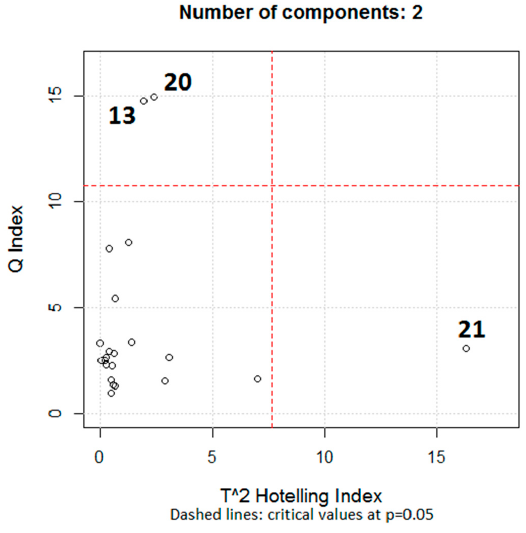
Figure 4. T 2 vs. Q diagnostic plot of the Principal Component Analysis (PCA) performed on the whole Filuferru dataset. Filuferru